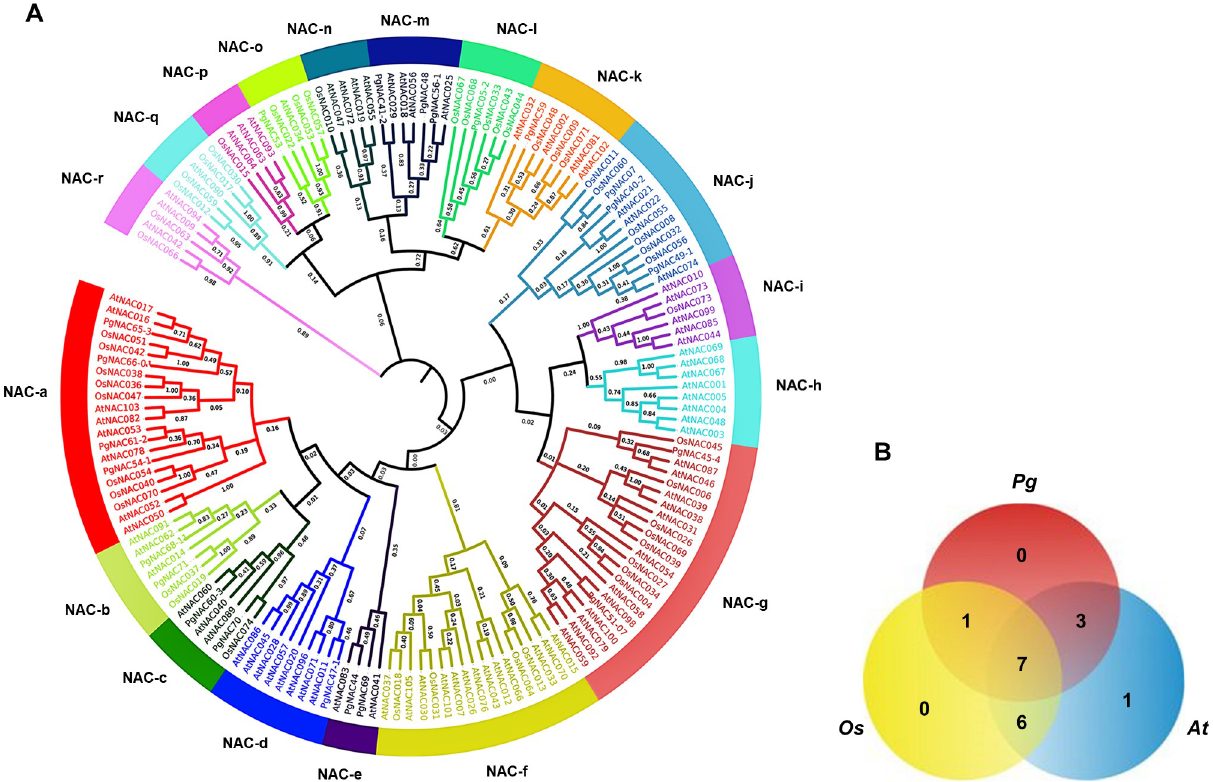
Fig 2. Phylogenetic tree of the PgNAC gene family. (A) The neighbor-joining (NJ) phylogenetic tree of the PgNAC genes with the AtNAC genes in Arabidopsis thaliana ( At ) and OsNAC genes in rice ( Oryza sativa , Os ). The subfamilies of the NAC gene families are defined from NAC-a through NAC- r. The tree was constructed with 10,000 bootstrap replications. (B) Comparison of the subfamilies among the PgNAC , AtNAC and OsNAC gene families. The numbers in the Venn diagram indicate the numbers of subfamilies shared among the three NAC gene families and the number of subfamilies specific for each species.